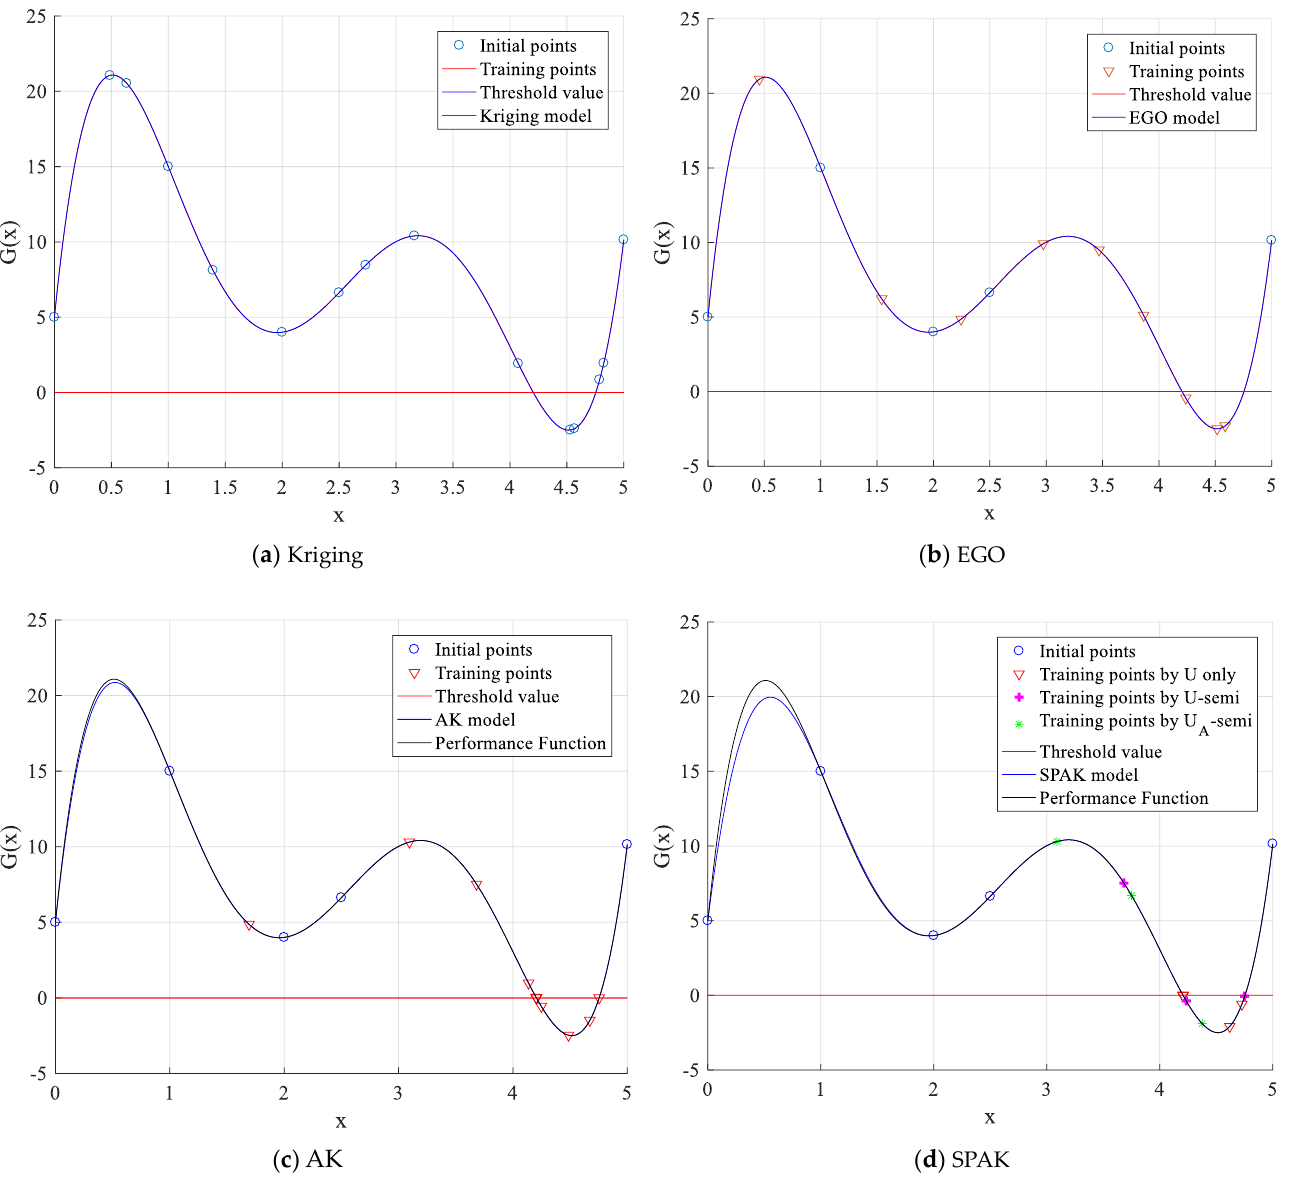
Figure 3. Training process of surrogate models for Example 1. Table 1. Results of adding training points for different methods for Example 1.